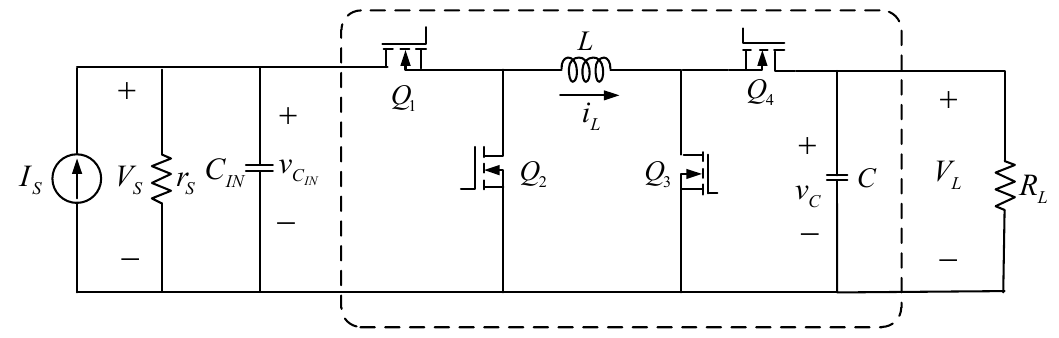
Figure 7. The current-fed four-switch type buck-boost converter